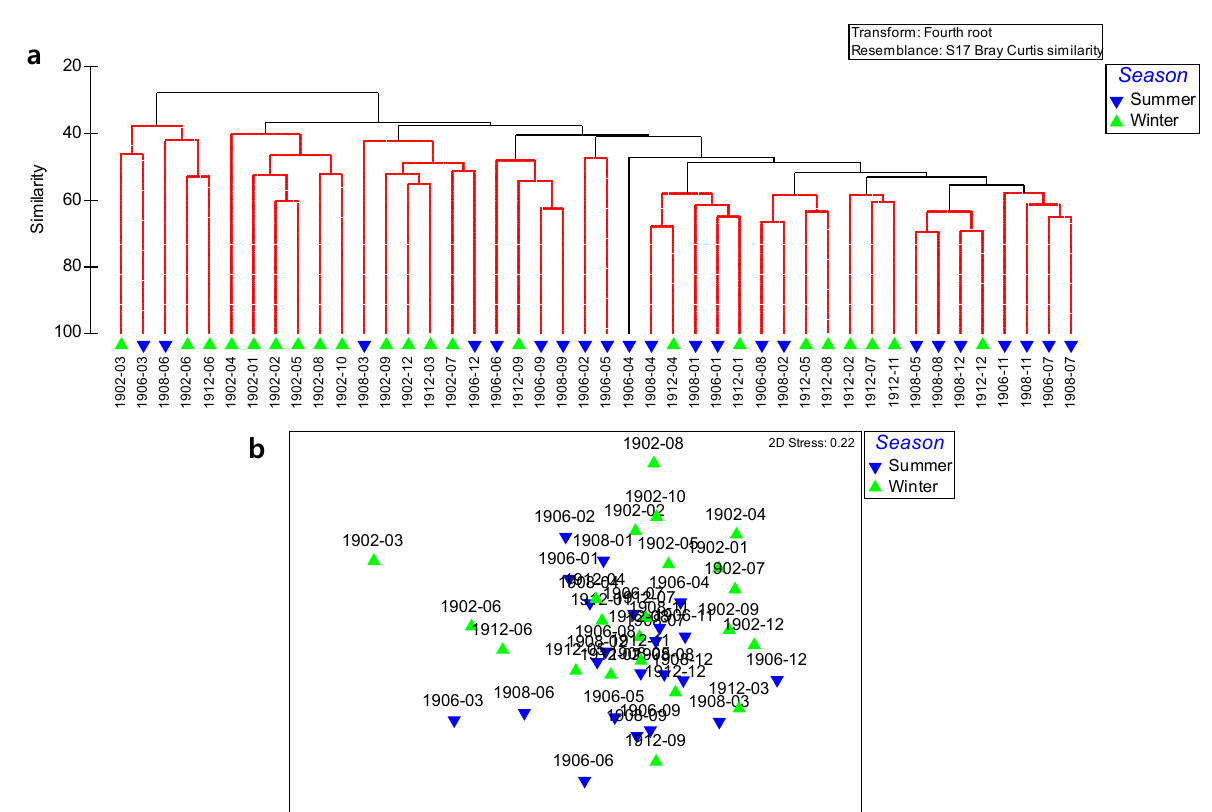
Figure 3. ( a ) Cluster analysis and ( b ) non-metric multidimensional scaling (nMDS) analysis of fourth root transformed polychaete species abundance at Ulleungdo island. Table 5. SIMPER analysis of polychaete species clusters (Av.Abund, average abundance; Av.Sim, average similarity; Av.Diss, average dissimilarity; Contrib %, contribution %; Cum %, cumulative %). Group Summer Average Similarity: 43.37